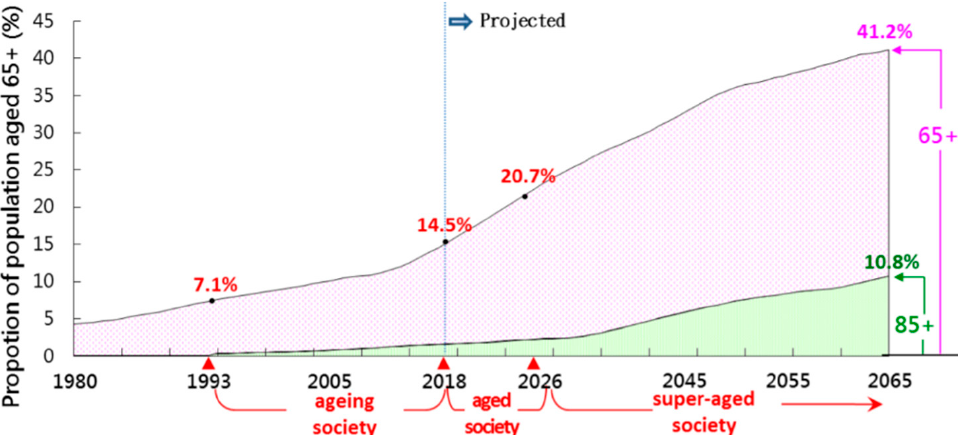
Figure 3. Population Projections for Taiwanese Elderly: 2018–2065 [10]. Data source: (adapted from https://www.ndc.gov.tw/en/cp.aspx?n=2e5dcb04c64512cc (accessed on 30 January 2022). (Source: National Development Council, 2018) .